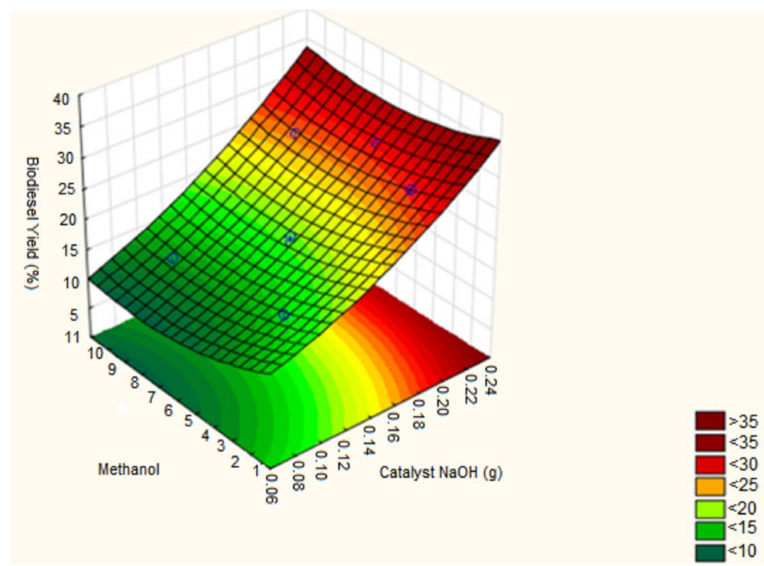
Figure 4. Response surface for frying-oil biodiesel mass-yield